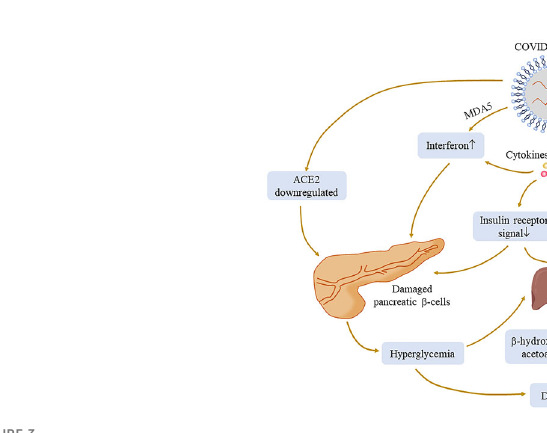
FIGURE 3 Possible mechanisms of hyperglycemia and its complication associated with COVID-19 vaccination. The injection of COVID-19 vaccines may cause a pathophysiological process similar to that of COVID-19 infection, such as ACE2 downregulation, cytokine production, and